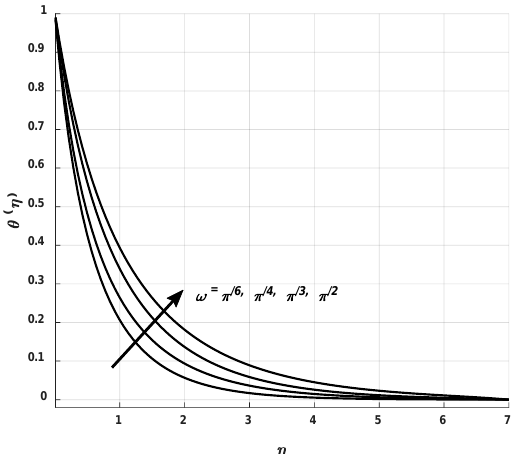
Figure 11. Effect of Pr on θ ( η ) .